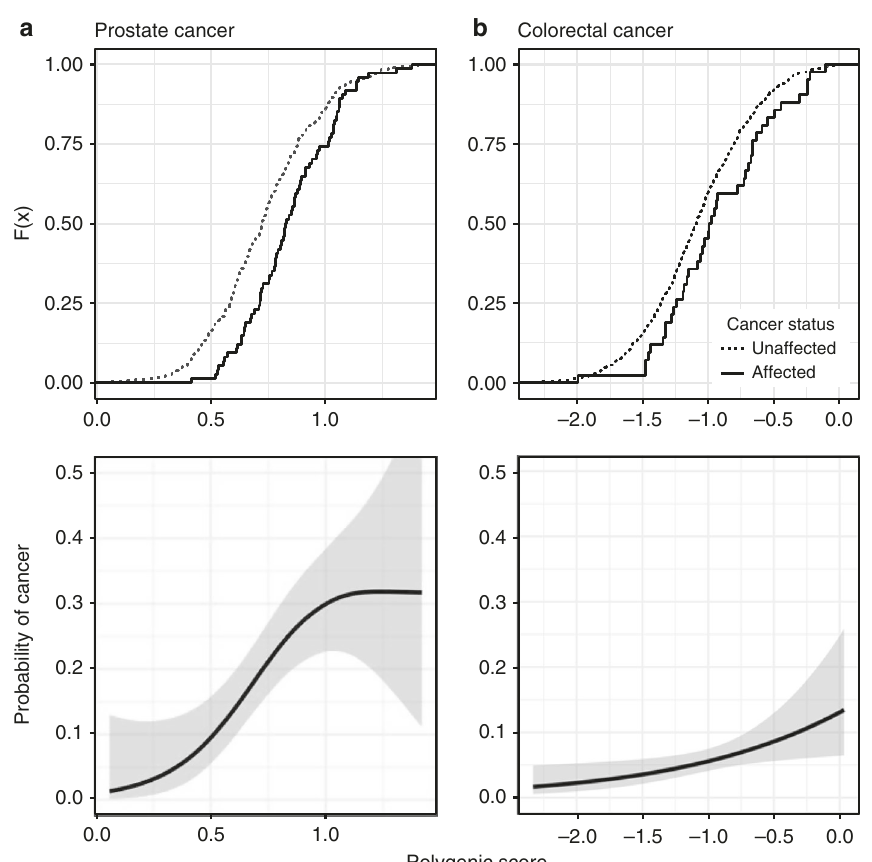
Fig. 2 Polygenic risk is strongly related to cancer diagnosis. Cumulative distribution functions (top panels) and associated probability of cancer diagnosis by age 70 (bottom panels) are shown for both prostate cancer ( a ) and colorectal cancer ( b ). Unaffected individuals are MGRB men (prostate), or all MGRB individuals (colorectal) and were completely cancer-free up to age 70; affected individuals were sourced from the 45 and Up Study cancer cohort and had recorded evidence of the relevant cancer diagnosis prior to age 70. Polygenic scores were computed based on reported loci and model coef fi cients 54,57 . Fits are from logistic regression using a GCV-penalised thin plate spline smooth; bands denote 95% con fi dence intervals around the